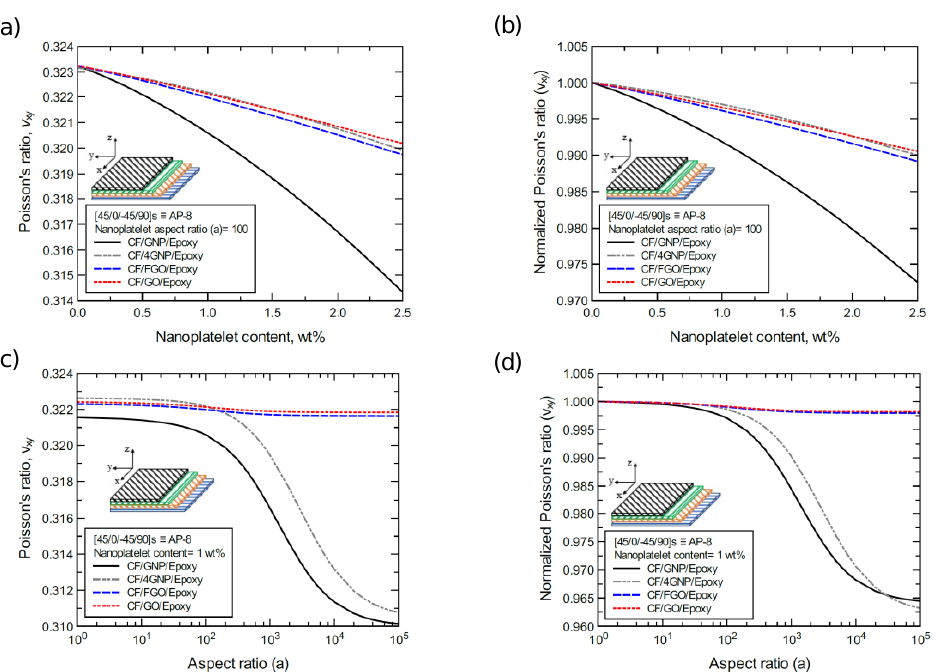
Figure 25. Comparison of the predicted in- plane Poisson’s ratio (ν xy ) for a [45/0/-45/90]s (AP-8)-laminated composite plate based on the nanoplatelet type, content, and aspect ratio; ( a ) predicted ν xy for various nanoplatelet contents at 100 aspect ratio, and the normalized response is shown in ( b ); ( c ) predicted ν xy for various aspect ratio values at 1.0 wt% nanoplatelet content, and the normalized response is shown in ( d ). The volume fraction of CF is 56%.